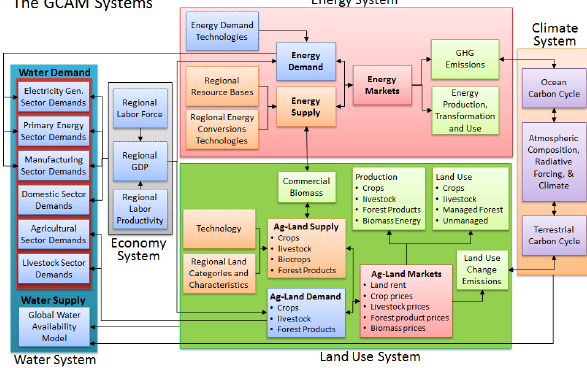
Figure 1: Schematic of the GCAM systems with links to the water system Figure 1. Schematic of the GCAM systems with links to the water system.